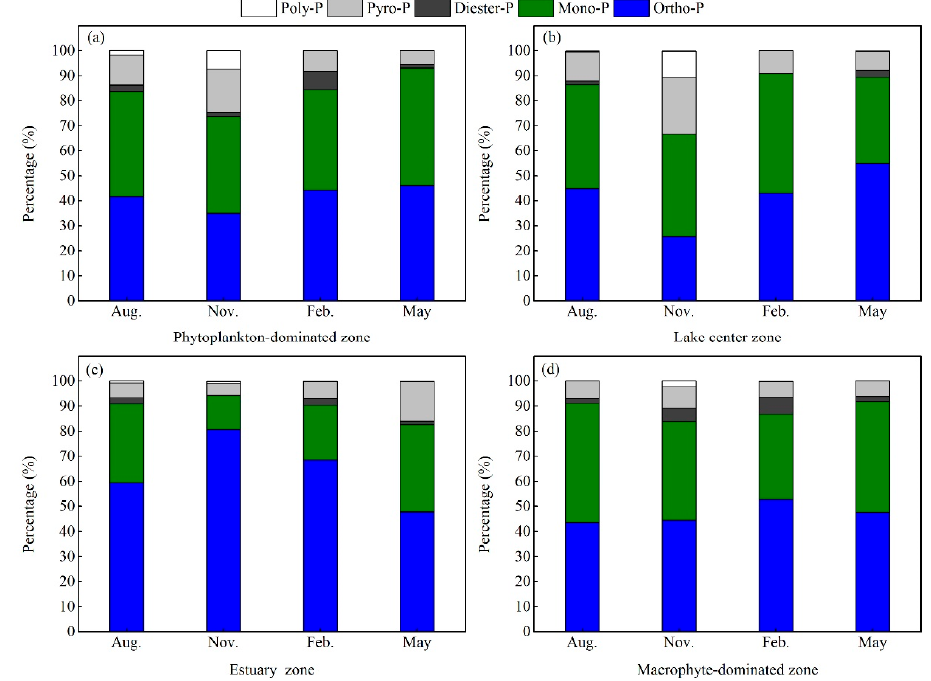
Figure 3. Percentages of each PP species in Lake Taihu: ( a ) autumn (November 2015); ( b ) winter (February 2015); ( c ) spring (May 2016); ( d ) summer (August